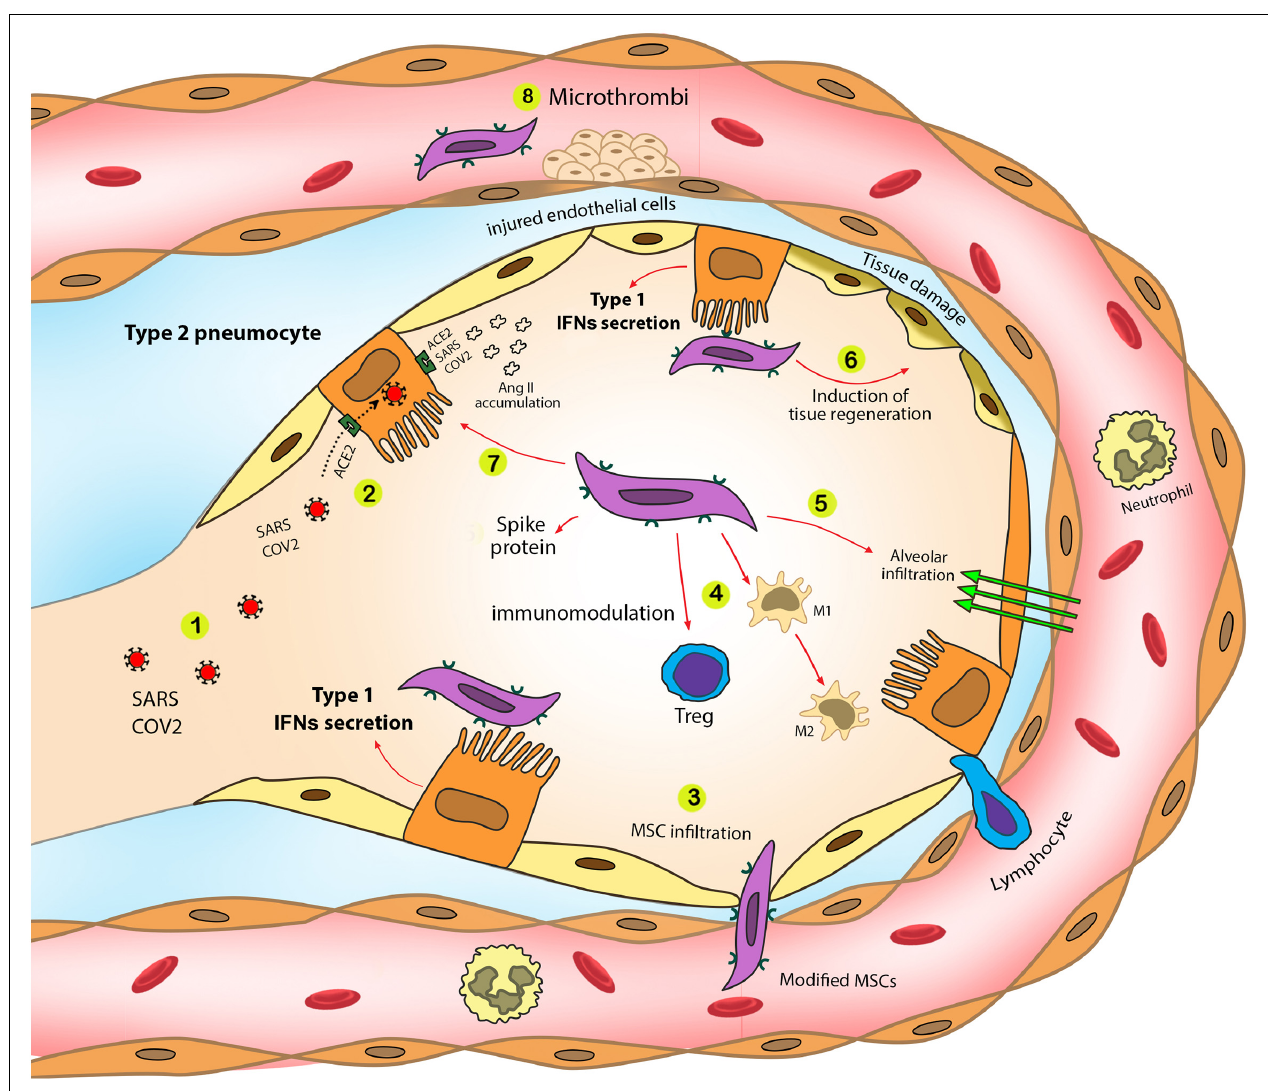
FIGURE 2 | SARS-CoV-2 pathogenic effects and the role of modified MSCs in the eradication of SARS-CoV-2 complications. Modified MSCs trigger type 1 IFN production in a targeted manner. Additionally, utilizing MSCs as mitochondrial carrier eliminates various COVID-19 complications and synergically improve mitochondrial therapy in COVID-19. 1. SARS-CoV-2 enters alveoli through airways. 2. SARS-CoV-2 infects type II pneumocytes through the ACE2 receptor. 3. Modified MSCs entrap in the lungs and infiltrate into the alveoli. 4. MSCs induce immunomodulatory effects that control cytokine storm during severe stages of COVID-19. Modified MSCs increase Treg cell activity and M1 to M2 macrophage switch, diminishing inflammatory mediator production by M1 macrophages. 5. Modified MSCs increase fluid clearance exudation from infected alveoli. 6. Modified MSCs can participate in tissue regeneration to eliminate chronic fibrosis due to COVID-19. 7. SARS-CoV-2 infection results in angiotensin II accumulation and following lung fibrosis. MSCs can modulate in angiotensin II production that reduces lung fibrosis. 8. MSCs modulate coagulopathies during